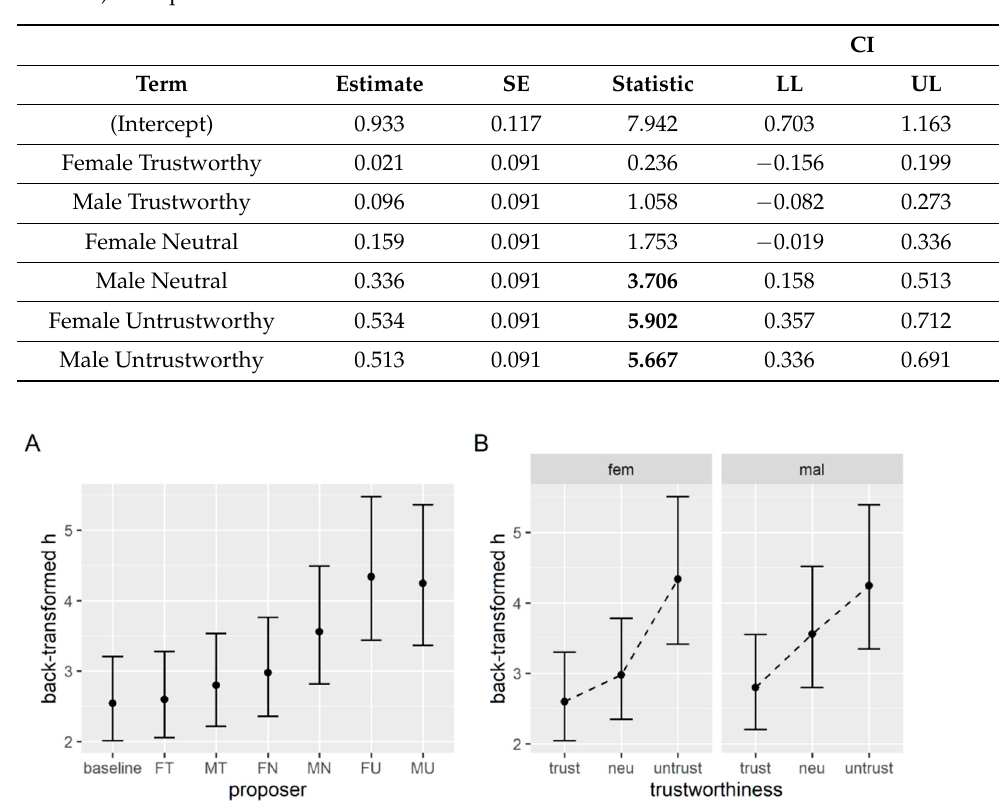
Figure 5. ( A ) Estimated marginal means of h parameters from the first model comparing baseline and each experimental condition. ( B ) Estimated marginal means of h parameters for each level of trustworthiness, with female (left) and male (right) proposers.